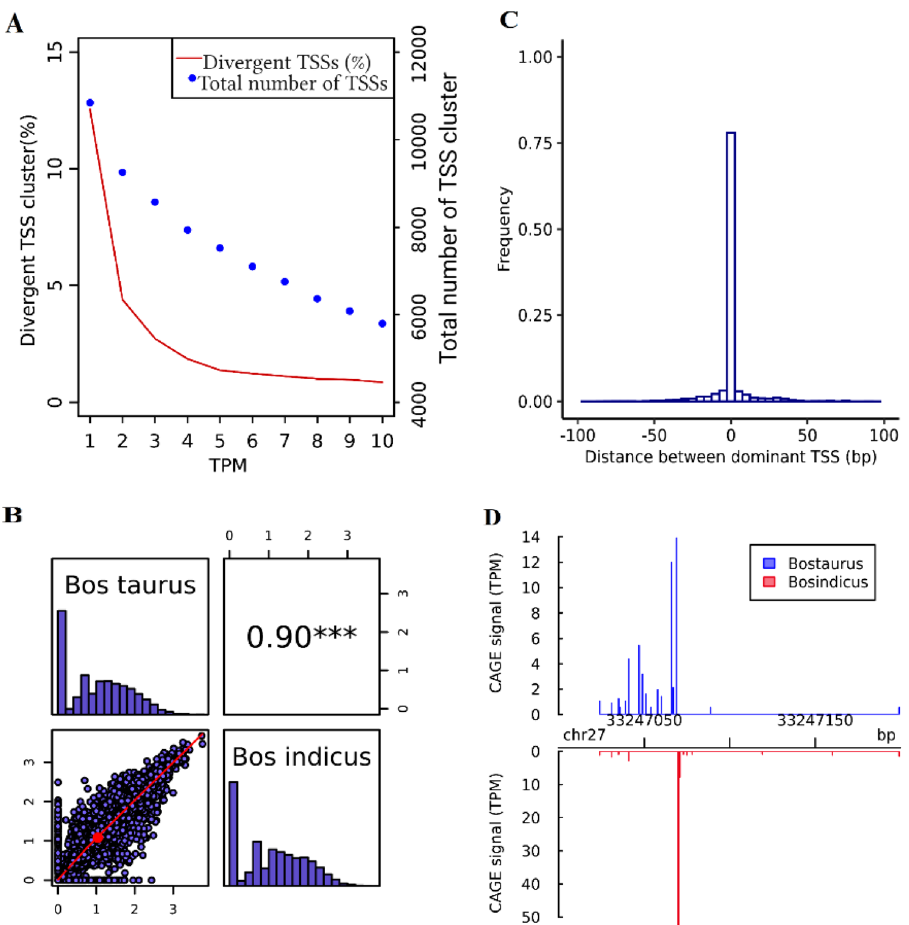
Fig. 4 Overview of comparison between Bos taurus and Bos indicus sub-species for adult spleen. A Total number of TSS clusters and their percentage of divergent TSS at different expression levels (TPM), B Pearson correlation of TSS diversity measured by Shannon index (the distribution of Shannon index is shown on the diagonal and on the bottom of the diagonal the bivariate scatter plots with a fi tted line are displayed. Also, on the top of the diagonal, the value of the correlation plus the signi fi cance level ( P -value < 0.001) as stars is shown), C Histogram of distances between Bos taurus and Bos indicus dominant TSS in consensus TSS cluster with at least 10 TPM level expression, and D An example of differential TSS usage observed in gene EIF4EBP1 across two subspecies ( P -value and FDR < 0.05; shifting score = 0.86). The annotated TSS based on the Ref-Seq gene using Apr.2018